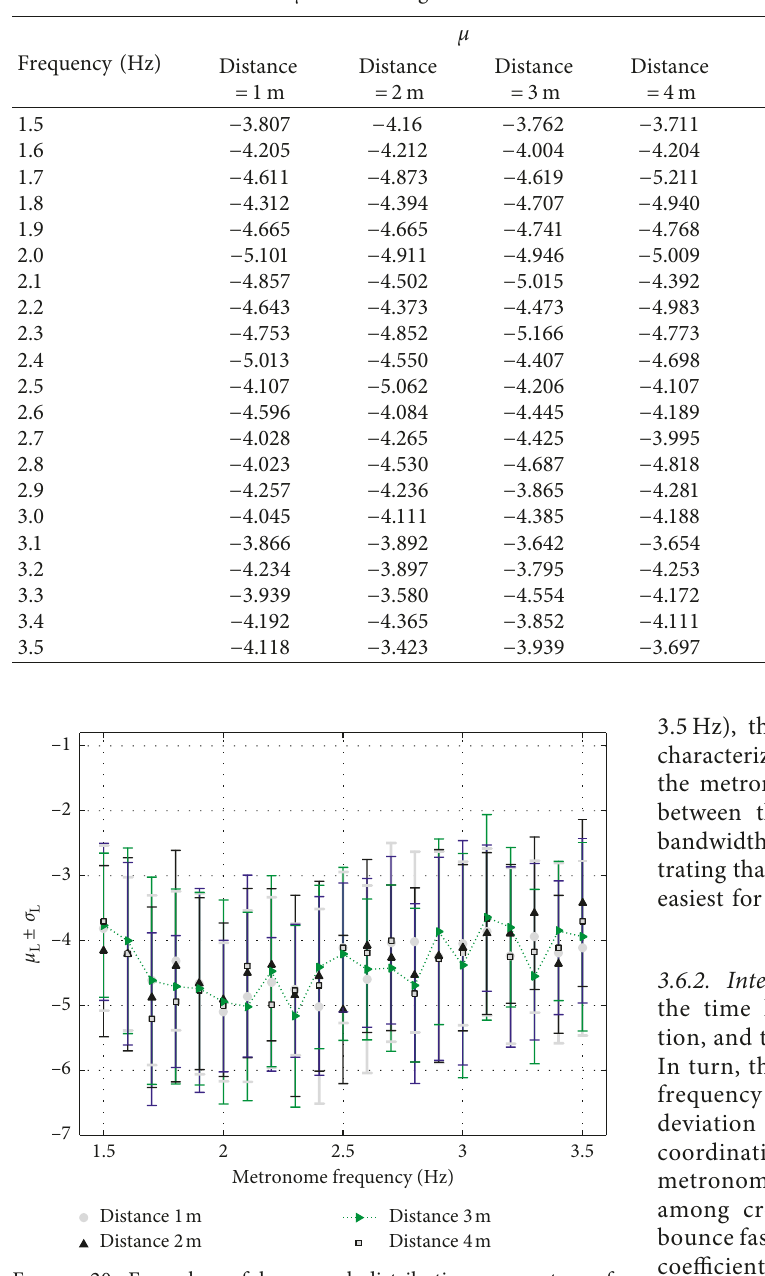
Table 4: μ and σ in lognormal distribution of coherence coefficients in the lateral direction.